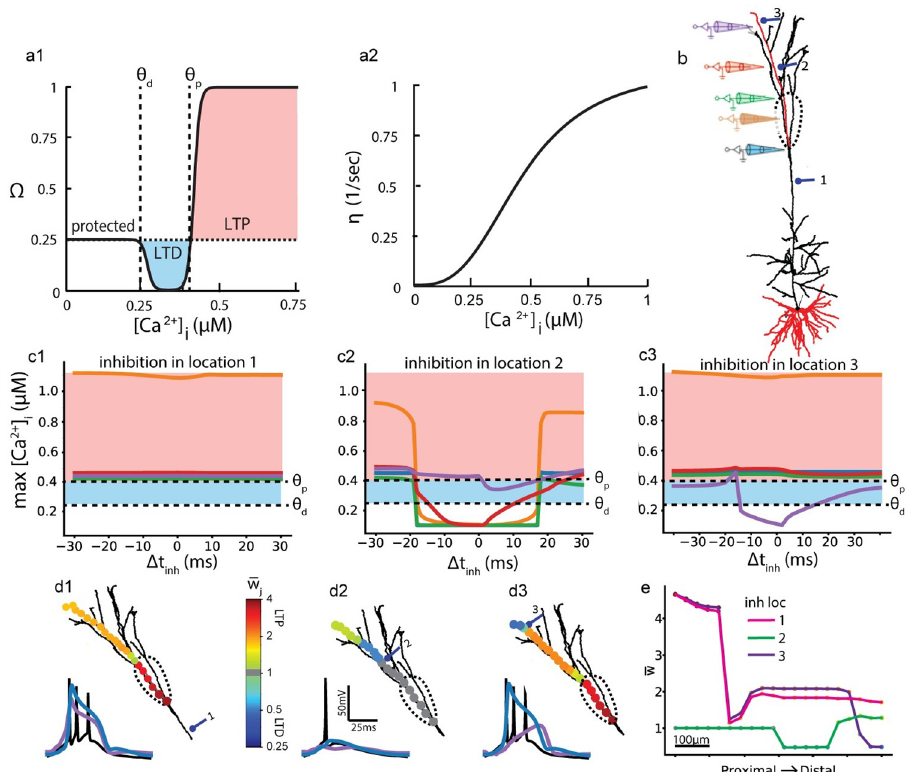
Fig 6. Impact of dendritic inhibition on somatic bursts and on plasticity of excitatory dendritic synapses. a1. Dependence of plasticity function, O , on intracellular Ca 2+ concentration, [Ca 2+ ] i . When [Ca 2+ ] i < θ d , the synaptic weights remain fixed (protected); for θ d < [Ca 2+ ] i < θ p , synapses undergo long-term depression, LTD (blue) and for [Ca 2+ ] i > θ p they undergo long-term potentiation, LTP (pink; see Eq (1) in Methods ). a2. Learning rate, η , as a function of [Ca 2+ ] i (see Eq (2) in Methods ). b. Model neuron and synaptic simulation parameters as in Fig 4 A . 70 basal and 40 tuft excitatory synapses were activated (the “input”) on the red branches simultaneously ( Δ t = 0) with σ = 10 ms (see Methods ). Electrodes and their respective color represent measurement locations of [Ca 2+ ] i . Numbered synapses correspond to the mean locations of 20 inhibitory synapses with peak conductance 1 nS per synapse. Dashed line denotes Ca 2+ hotspot. c1-c3. Maximal [Ca 2+ ] i along the apical dendrite at five locations (corresponding colored electrodes in b ) following the input as a function of timing, Δ t inh , between excitation and inhibition, for each inhibitory location (#1-#3 in b ). Dashed lines mark threshold values, θ p and θ d , as in a 1. Blue shading—LTD; pink—LTP; white— protected. d1. Up: Twenty excitatory synapses are superimposed on the dendritic tree, color coded by their respective synaptic weights after activation of inhibition at location #1. The weights are normalized to their initial value (1). Changes are due to the plasticity protocol during 10 input repetitions for the case of Δ t inh = 0. Lower traces: Somatic (black); nexus Ca 2+ spike (blue trace at respective blue electrode in b ) and distal NMDA spike (purple at respective purple electrode in b ) for inhibition location #1. d2. As in d 1, with inhibition at location #2—burst and Ca +2 spike suppressed. d3. As in d 1, with inhibition at location #3—distal NMDA spike suppressed, burst is unaffected. e. Changes in synaptic weights following the plasticity protocol as a function of synapse location along the tuft branch, for each of the three inhibitory locations. electrodes in Fig 6 B ), the [Ca 2+ ] (corresponding red and purple lines in Fig 6 C 2) is more sen- i sitive to the timing of inhibition. This may be explained by the fact that the voltage response is all-or-none in the hotspot (blue inset traces in Fig 6 D ), while the distal branches (purple) may exhibit more variable levels of [Ca 2+ ] due to the synergistic interplay between NMDA current I and VGCCs voltage dependence. For this inhibition location for Δ t = 0, the somatic burst is inh suppressed and so are the Ca 2+ spike at the hotspot and the distal NMDA spike (Fig 6 D 2). This severe dendritic voltage attenuation will lower the maximum distal [Ca 2+ ] only slightly if i active after excitation (Fig 6 C 2 purple line, similarly to NMDA spike suppression in [40]), but enough to switch between LTP and LTD.